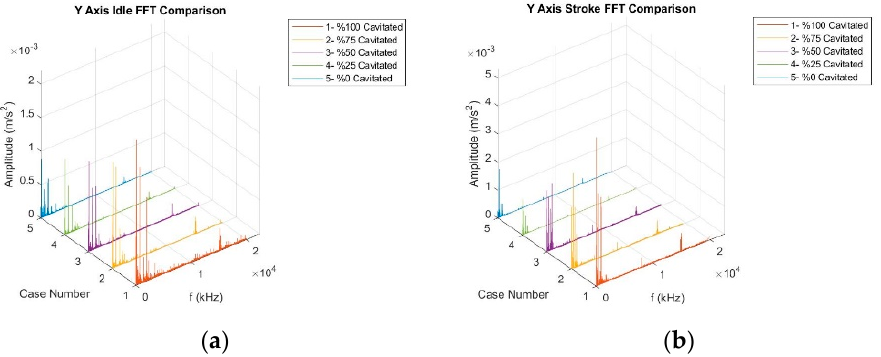
Figure 5. Contaminated oil vibration characteristic of ( a ) Y-axis idle and ( b ) Y-axis stroke.